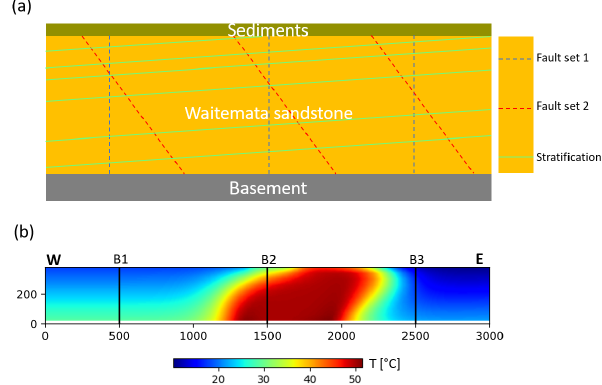
Figure 1. Geological and thermal conditions of the Waiwera geothermal site. (a) Structural elements of the aquifer, (b) interpo- lated temperature